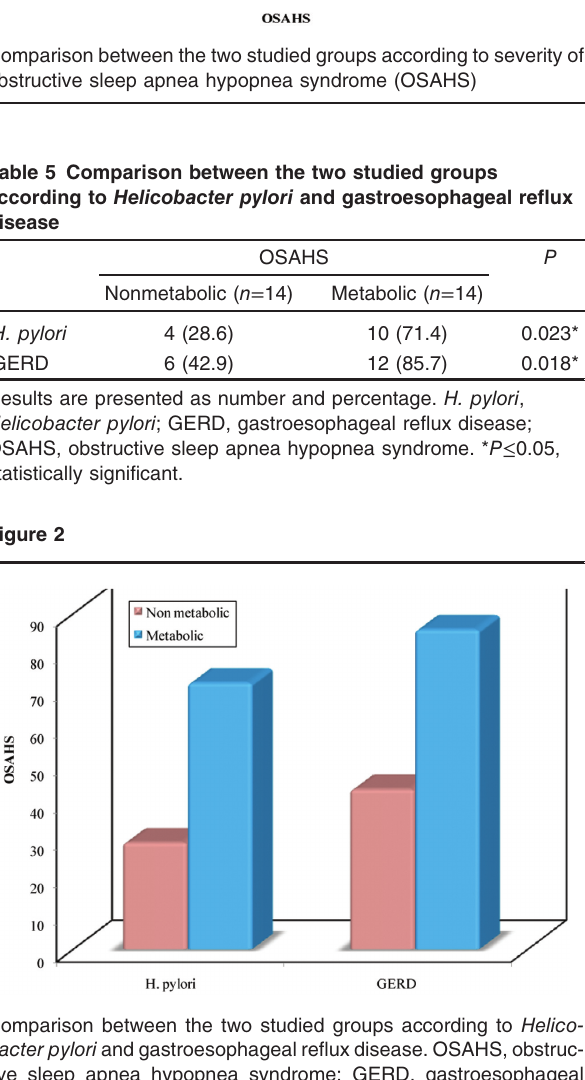
The prevalence of Helicobacter pylori infection and gastroesophageal reflux disease in patients with different comorbidities